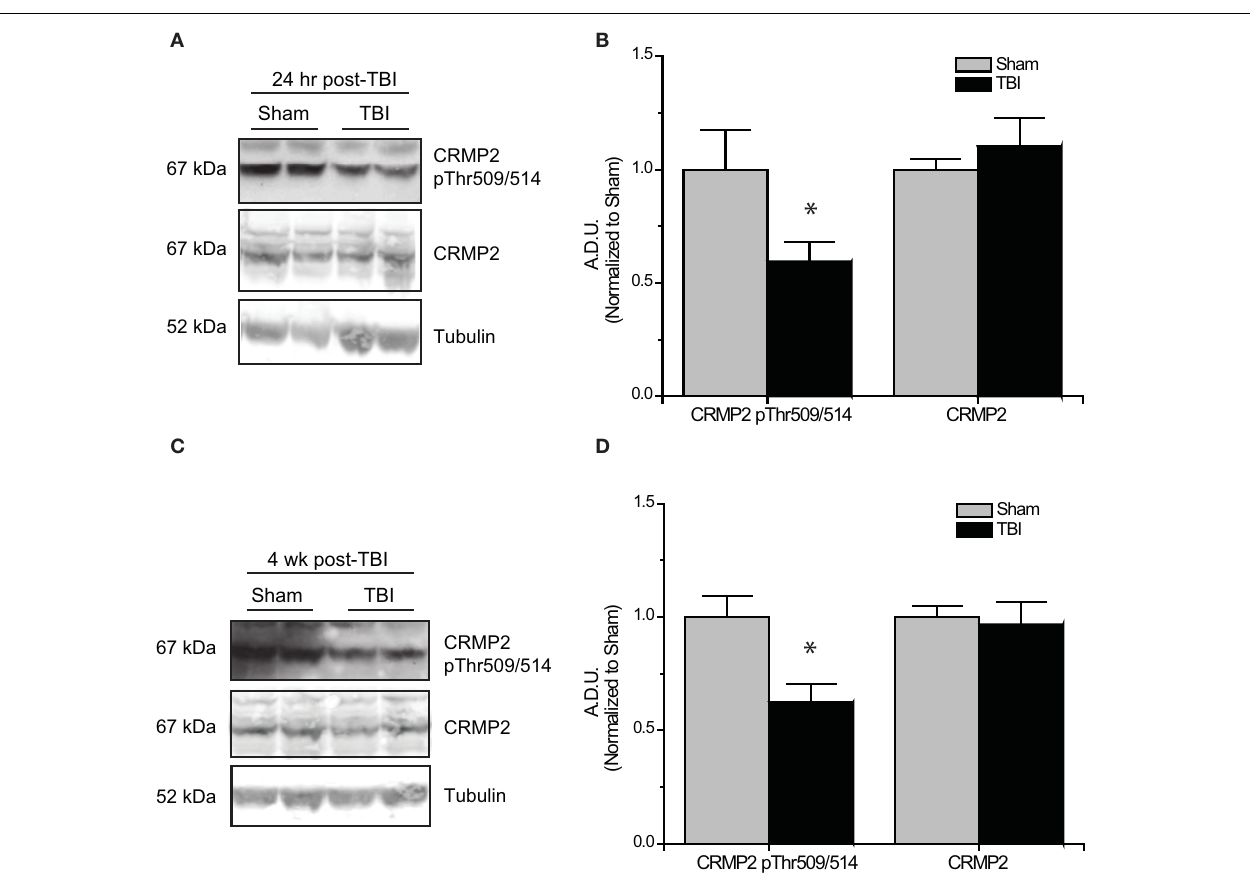
FIGURE 5 | Changes in CRMP2 phosphorylation by GSK3 β following TBI. (A) Western blots of GSK3 β -phosphorylated and total CRMP2 from hippocampal tissue 24h following TBI. (B) Summary of CRMP2 pThr509/514 and total CRMP2 levels 24h following TBI (raw data represents protein of interest normalized to tubulin and further normalized to sham to allow for easy comparison) [data is represented as arbitrary